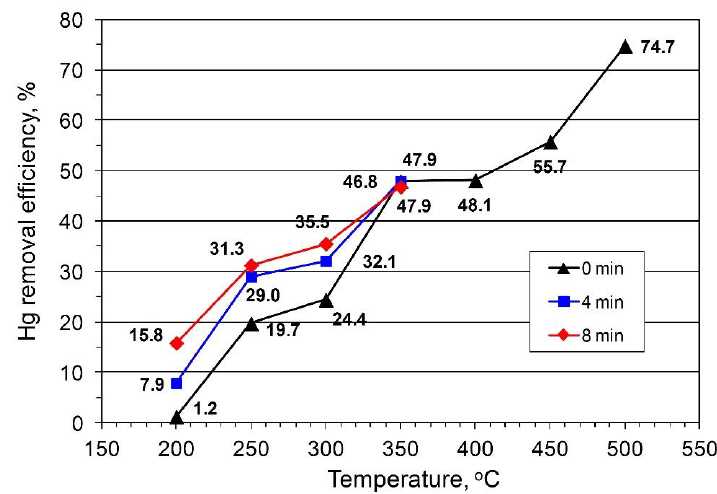
Figure 2. The average percentage efficiency of Hg removal from coal under low-temperature pyrol- ysis for hard coals (HC1, HC2, HC3); Dependence on process temperature at different residence times (0, 4, 8 min). (0, 4, 8 min).